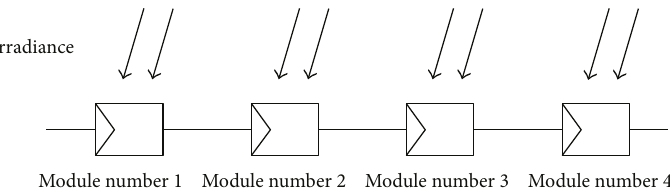
Figure 6: The block diagram of the experimental PV array.